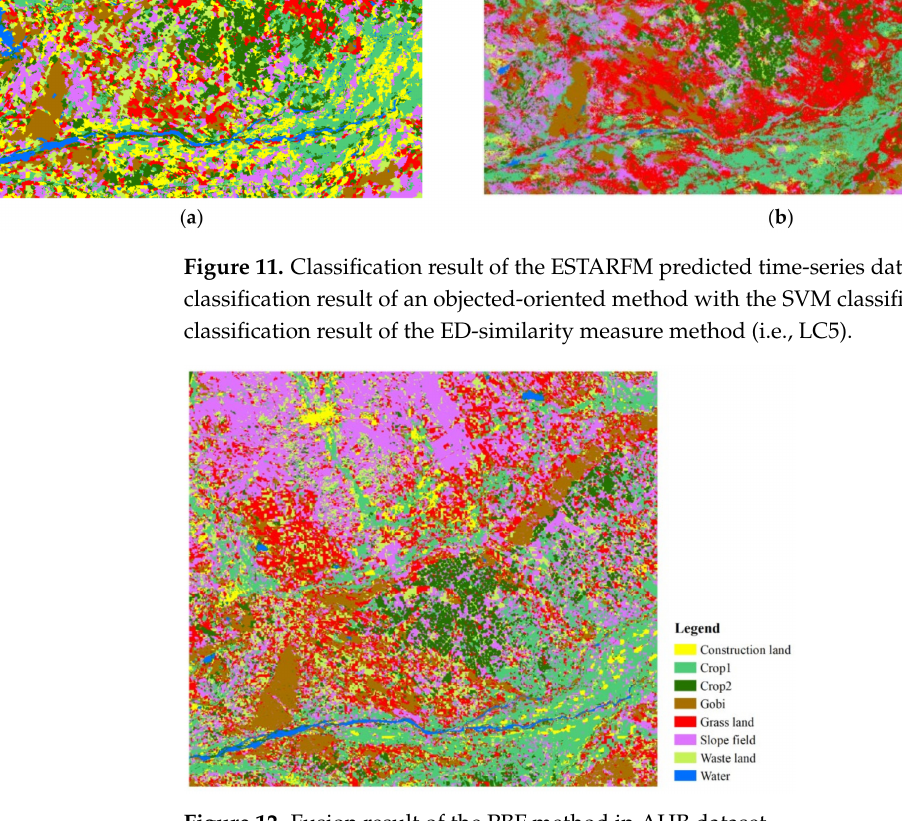
Figure 12. Fusion result of the PBF method in AHB